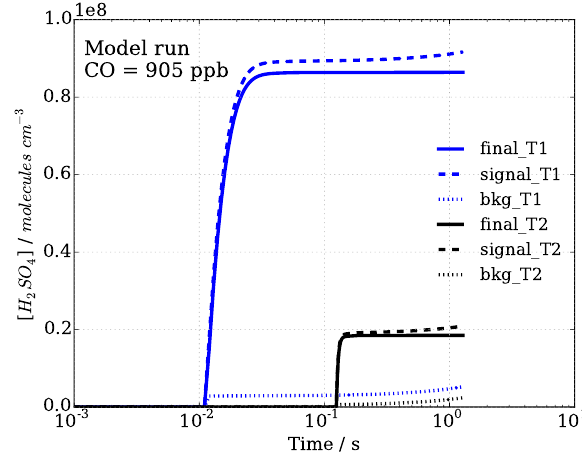
Figure 4. Sulfuric acid concentrations with time, representing progression in sample flow tube from inlet tip to ionization re- gion, for signal and background modes (dashed and dotted lines, respectively), as well as the calculated difference, leading to final [ H 2 SO 4 ] T1 = [ OH ] T1 and final [ H 2 SO 4 ] T2 = [ OH ] T2 concen- trations (solid lines) in titration zones 1 (T1) and 2 (T2), which are used to calculate OH